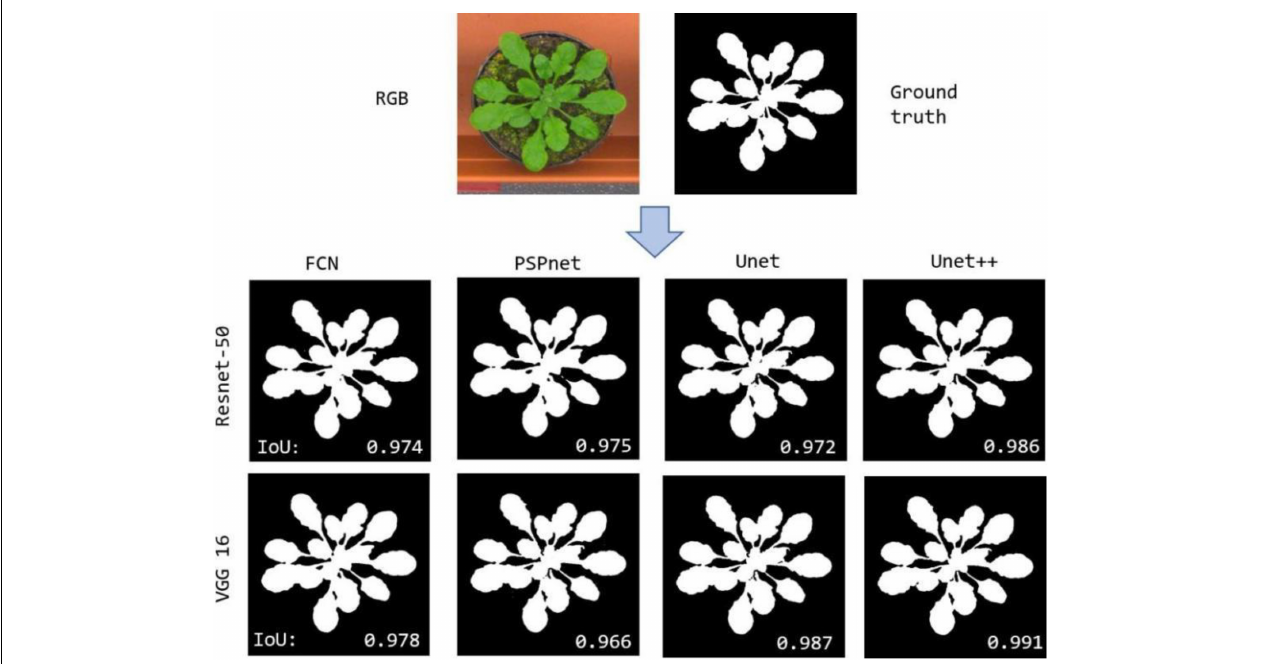
FIGURE 4 | Comparing segmentation results on the same RGB